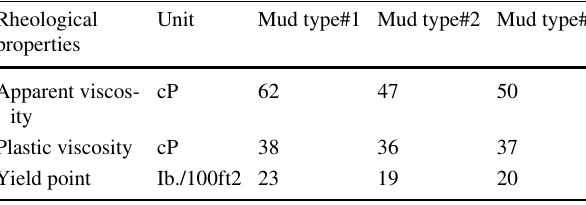
Table 4 Rheological properties of different mud